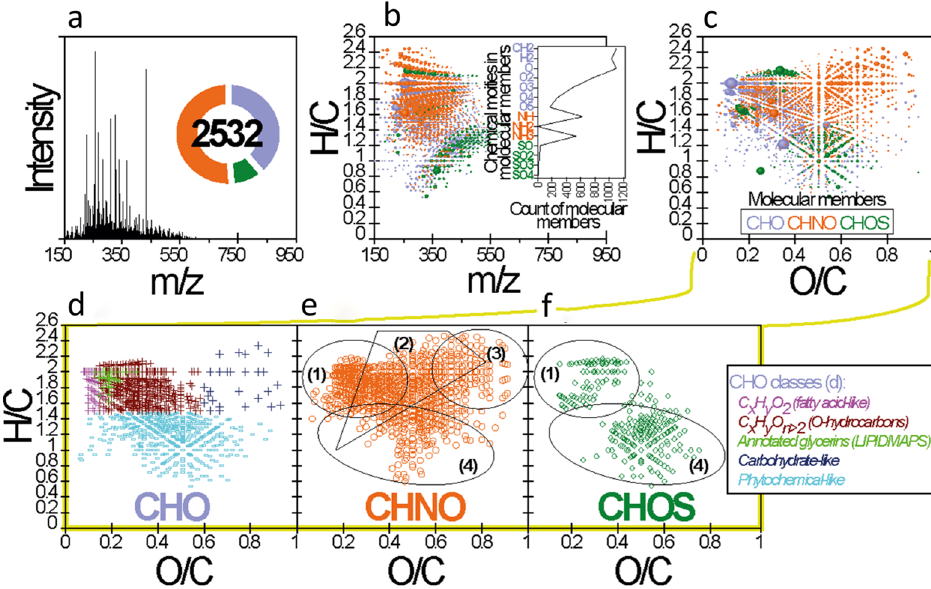
Figure 3. Main results obtained from the ESI(-)-FTICR-MS analysis. ( a ) Mass spectrum (150–950 Da) of the Upper Gossan sample 010,109–1. Inset number in ( a ) represents the total number of assigned molecular members (i.e., CHO, CHNO and CHOS). ( b ) and ( c ) H/C ratio versus mass-to-charge ( m/z ) plot and van Krevelen diagram of all assigned molecular members, respectively (color-coded dots represent molecular members CHO, blue; CHNO, orange; and CHOS, green, while circular areas indicate relative mass peak intensity). Inset in ( b ) represents the frequency histogram of the exact mass differences corresponding to CH 2 , H 2 , O n(1≤n≤5) , NH n(1≤n≤3) , and SO n(1≤n≤4) (error range 0.1 ppm). ( d ), ( e ) and ( f ) represent compound classes included in CHO, CHNO and CHOS-molecular members, respectively. Highlighted areas in ( d ), ( e ) and ( f